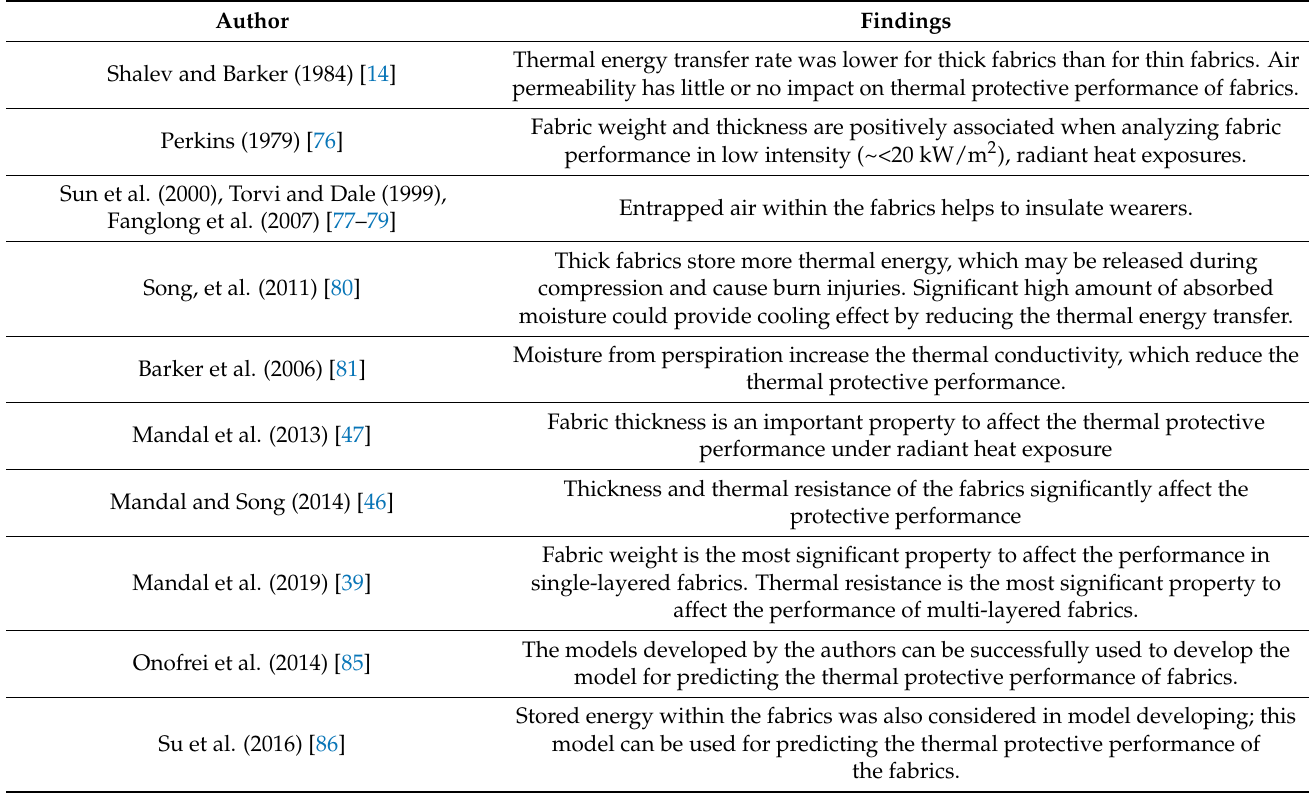
Table 2. Thermal protective performance under radiant heat